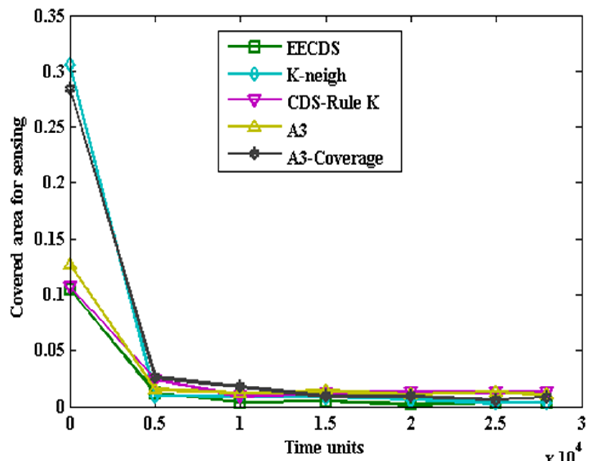
Figure 6 . Network lifetime for sensing coverage